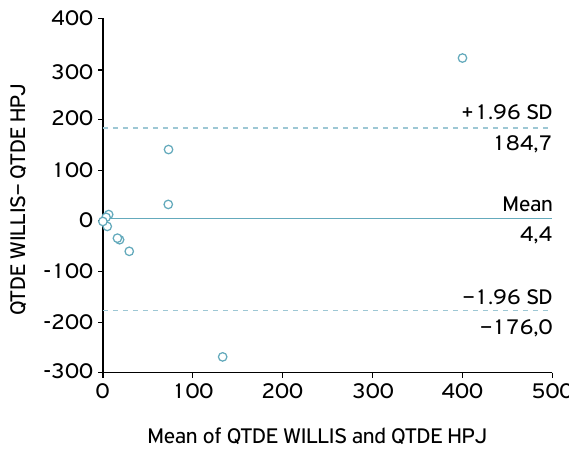
Figure 3. Joint comparison of all positive evaluations between HPJ and Willis